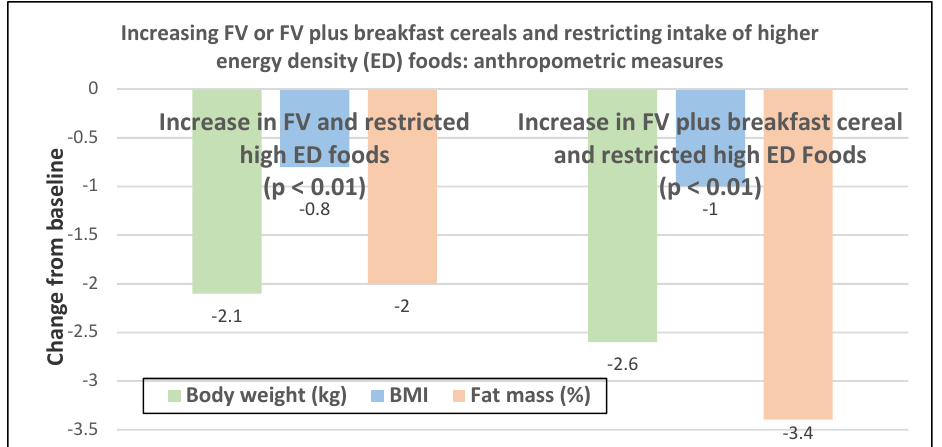
Figure 11. Anthropometric changes with increased intake of fruit and vegetable (FV) or FV plus